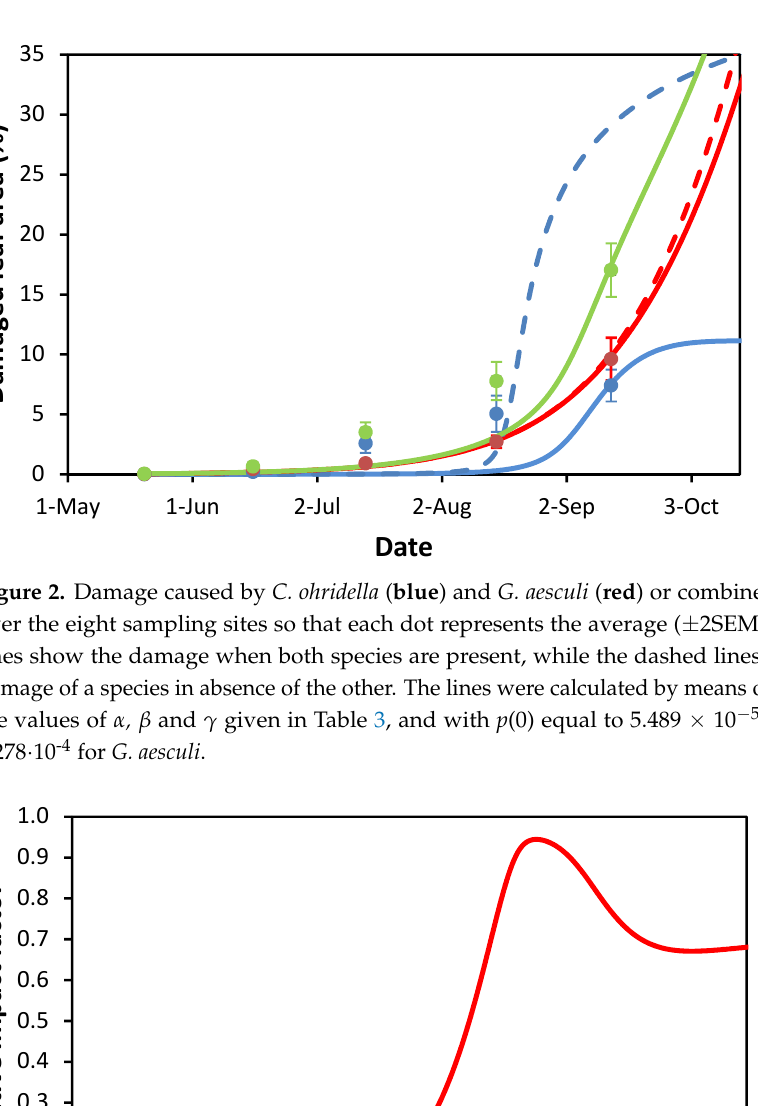
Table 4. Correlations between damages caused by C. ohridella and G. aesculi assessed at two different sampling occasions. Periods